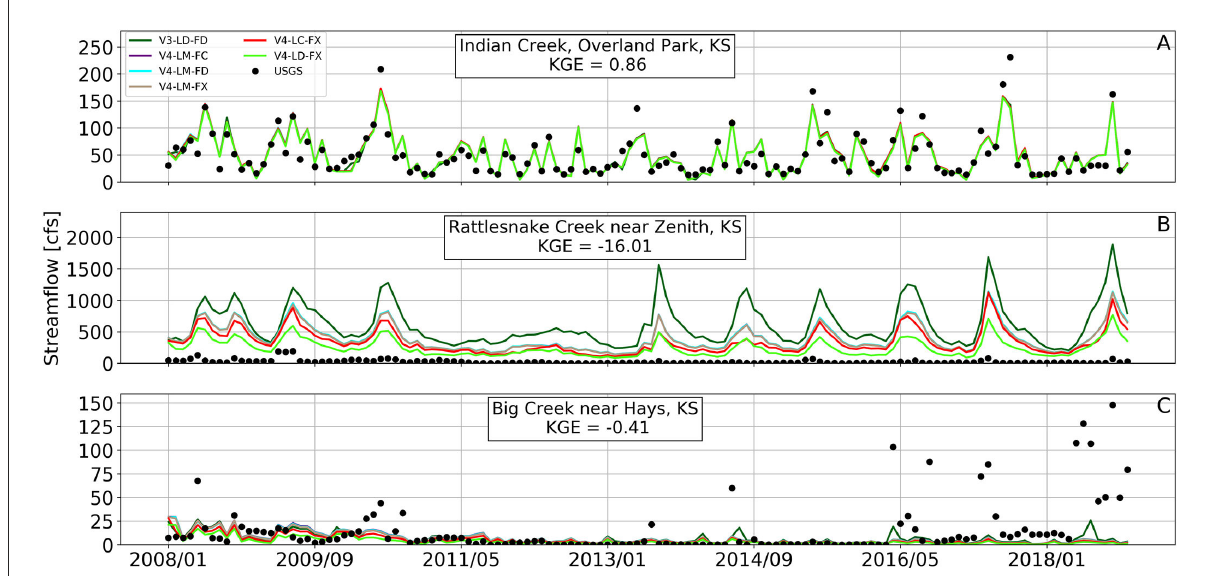
FIGURE10 Comparison of monthly simulated streamflow time series with USGS gauge measurements for selected gauges with (A) maximum average KGE (Indian Creek, Overland Park, KS), (B) minimum threshold KGE, (Rattlesnake Creek near Zenith, KS), and (C) minimum average KGE value (Big Creek near Hays,